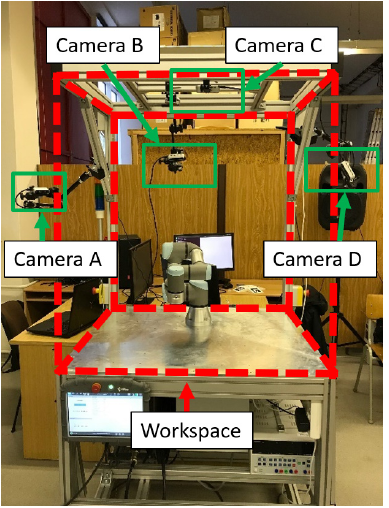
Figure 3. Workspace with robot UR3.